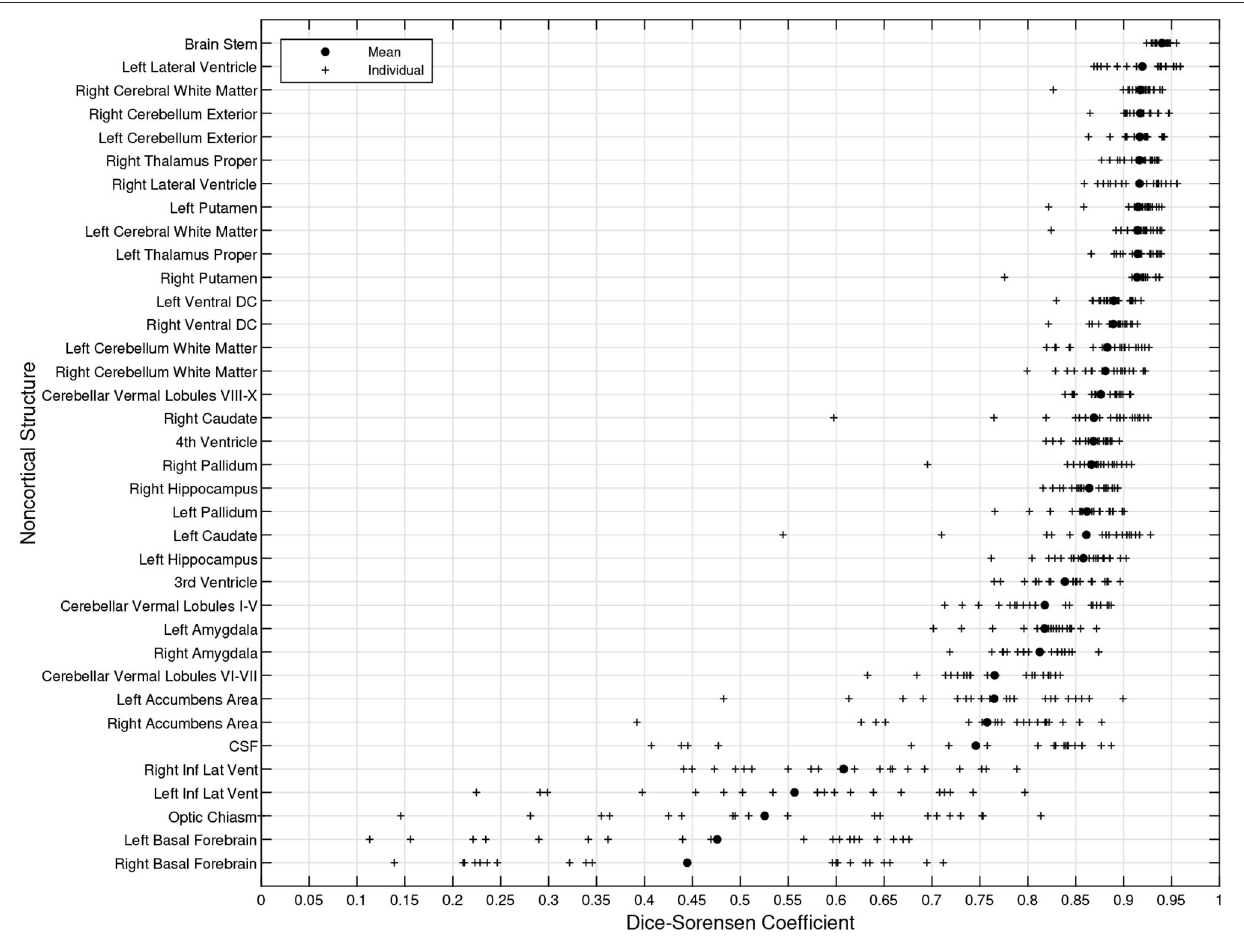
Frontiers in Neuroscience |